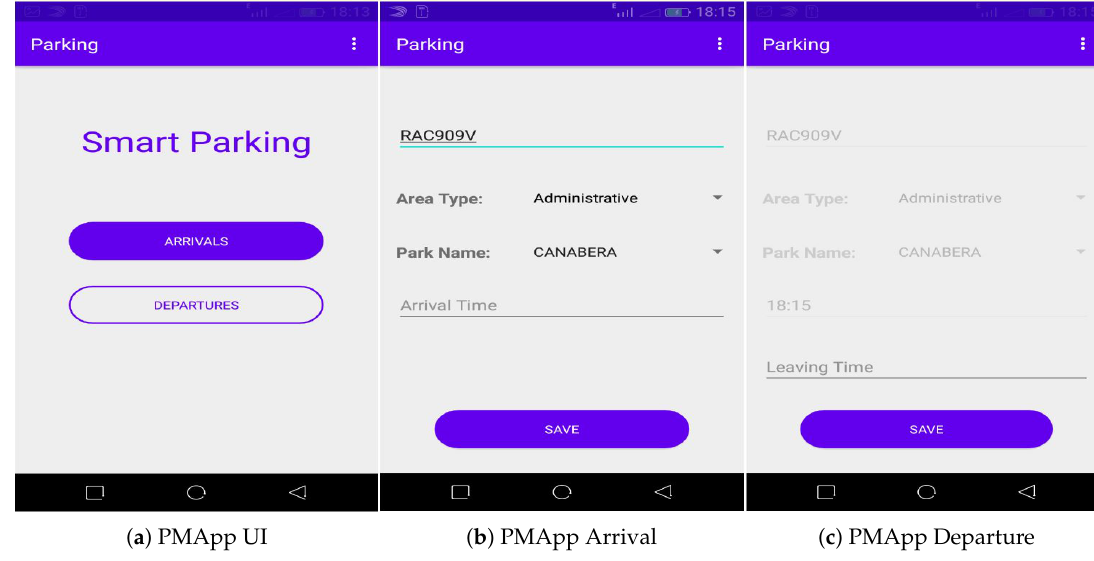
Figure 7. Parking Management Application (PMApp).